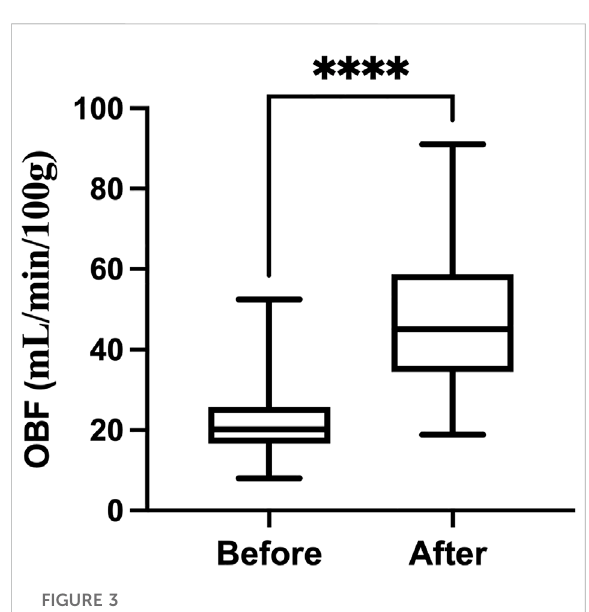
FIGURE 3 Changes in OBF before and after dobutamine injection.